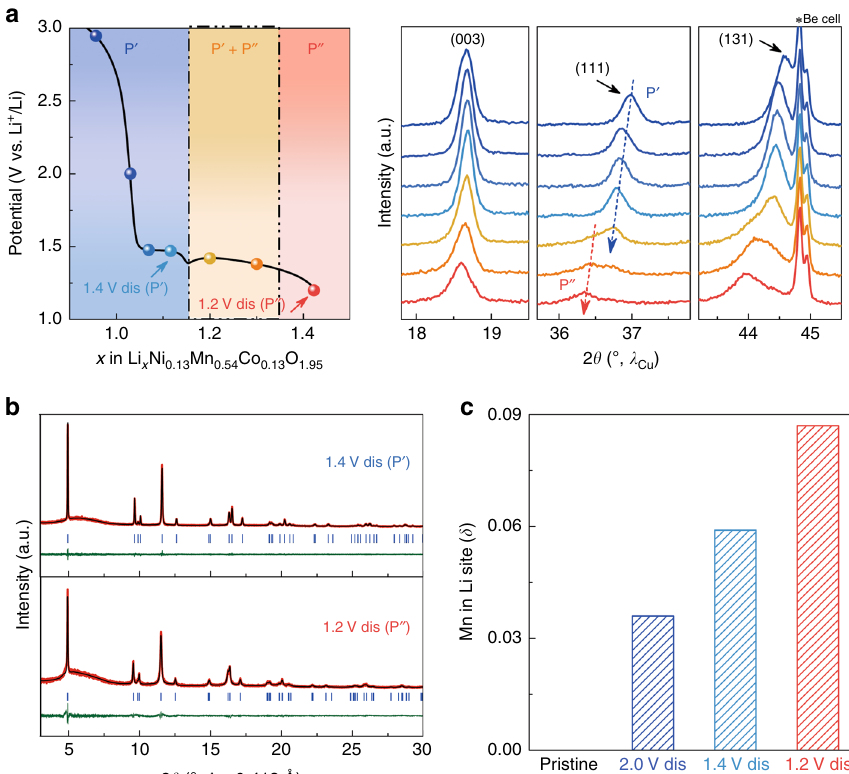
Fig. 5 Structural evolutions during low-potential discharge process. a Selective galvanostaic discharge curve (left side) and selective regions ((0 0 3), (1 1 1), and (1 3 1) diffraction peaks) of operando XRD patterns (right side) collected upon discharging Li-rich NMC from 3.0 down to 1.2 V, after 4.8 V charge and 3.0 V discharge (see Results for the complete discharge in Supplementary Fig. 13). Note that the dashed blue arrow marks the evolution of phase P ′ and the dashed red arrow indicates the growth of phase P ″ , respectively. b Rietveld re fi nements of synchrotron XRD patterns for the samples collected after 1.4 V (phase P ′ ) and 1.2 V (phase P ″ ) discharge. c Evolution of Mn migration in interlayer octahedral Li sites ( δ ) in the pristine phase, and the phases collected at 2.0, 1.4, and 1.2 V discharge state after 4.8 V